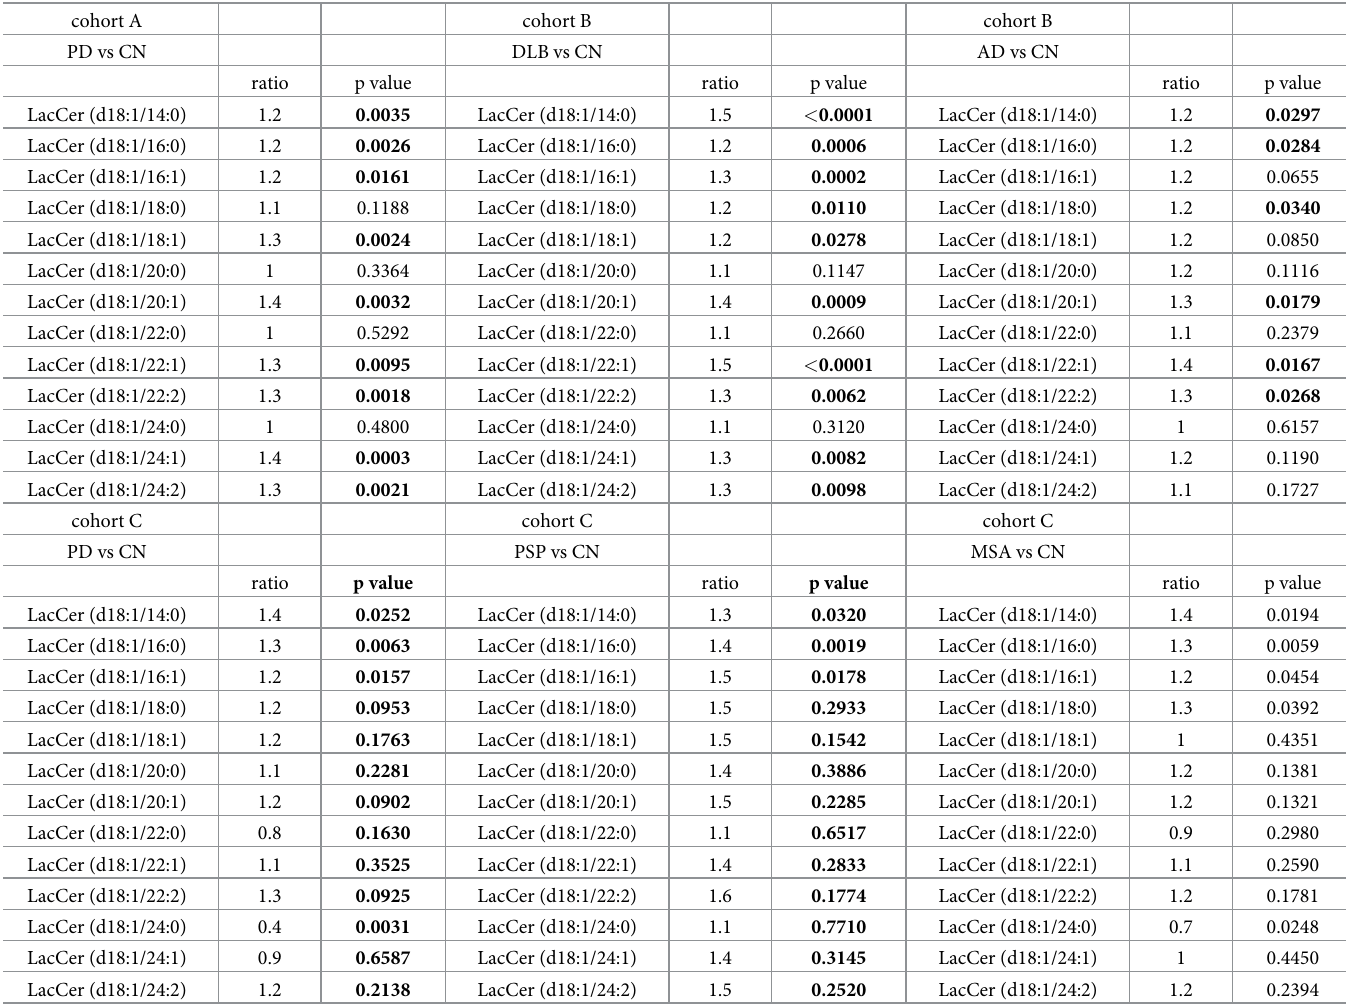
Table 3. Plasma All LacCer levels in neurodegenerative